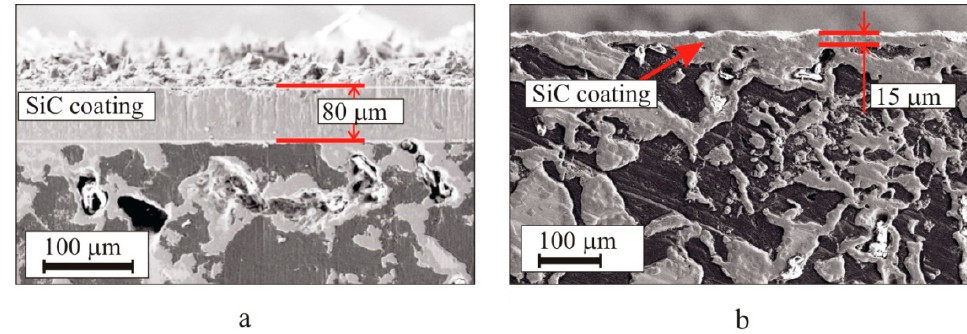
Figure 9. Cross section of a SiC-C-Si ceramic substrate with a deposited protective gas-tight SiC thick ( a ) and thin ( b ) coating.